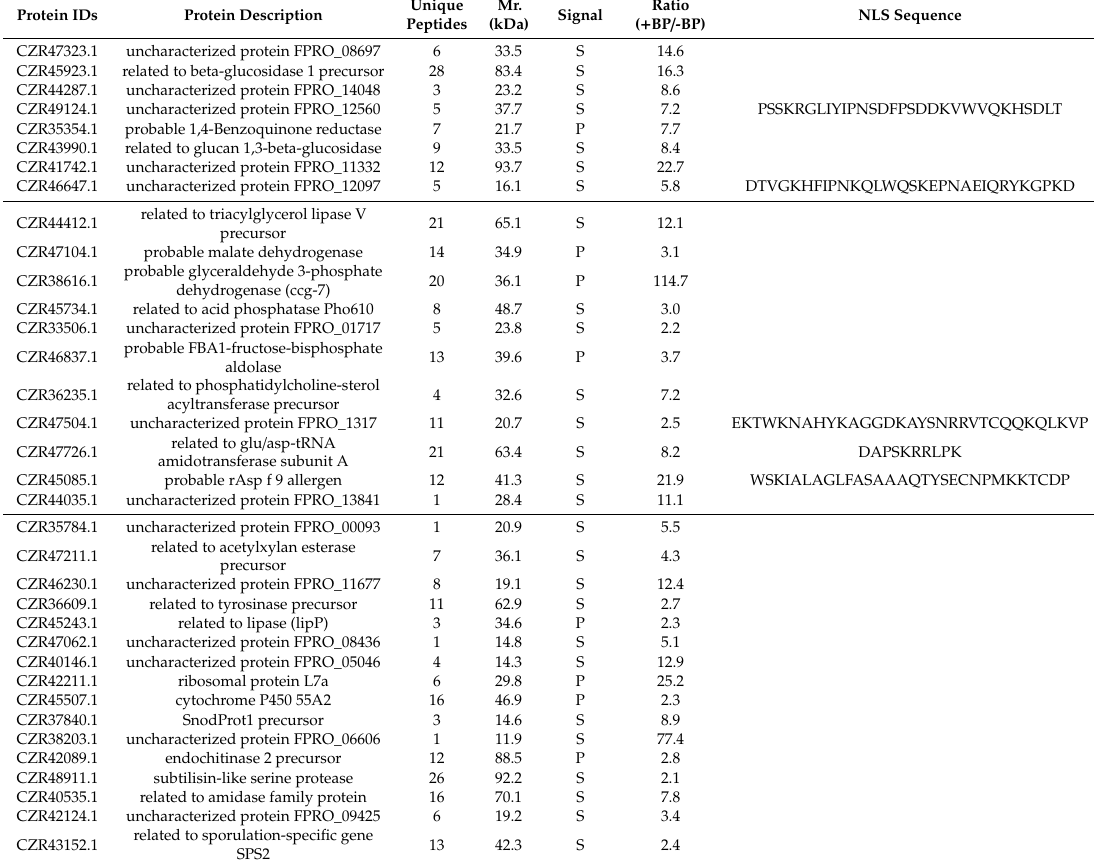
Table 2. Summary of the secreted proteins of F. proliferatum identified with higher abundances in the + BP sample. Mr: Molecular weight. The ratio ( + BP / − BP) was calculated according to the normalized spectral protein intensity (LFQ intensity) ratios of ( + BP: −